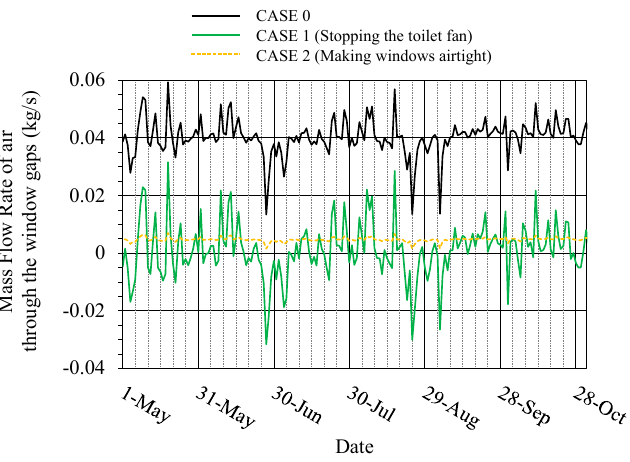
Figure 12. Daily averages of moisture inflow to the storage room in CASES 0, 1, and 2. The daily average mass flow rates of air through the window gaps (path 15) in CASES 0, 1, and 2 are shown in Figure 13. Positive values indicated the inflow of outdoor air into the north side buffer space, while negative values indicated the outflow. There was a constant inflow of outdoor air of about 0.0133 to 0.0569 kg/s in CASE 0, and the average value from June to September was 0.0396 kg/s. In CASE 1, the flow rate of air fluctuated between − 0.0315 and +0.028 kg/s with alternating inflows and outflows, and the average flow rate was 0.00064 kg/s. In CASE 2, there was a constant inflow of about 0.005 kg/s. The fluctuations were slight, and the average was 0.0047 kg/s.